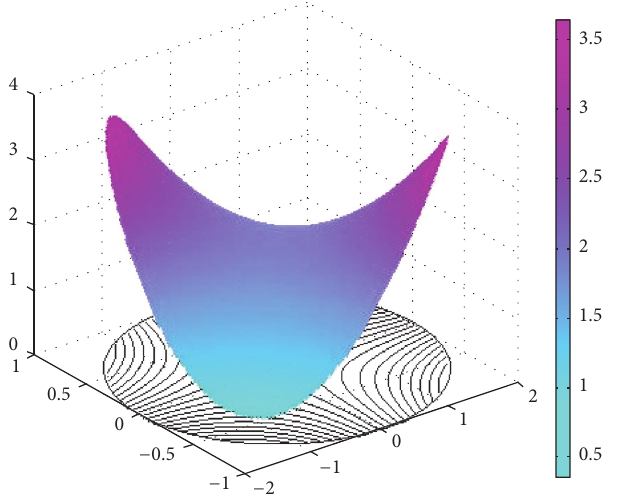
Figure 2: Cross-sectional torsional warping 𝜙 ; 𝑎 = 2 , 𝑏 = 1 ; 𝑘 1 = 1 , 𝑘 = 𝑐 = 2 . Color spectrum: 𝜙 . 2